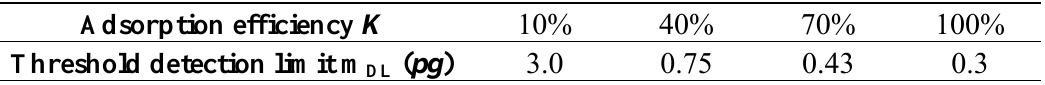
Table 1. The calculated detection limit for formaldehyde for various adsorption